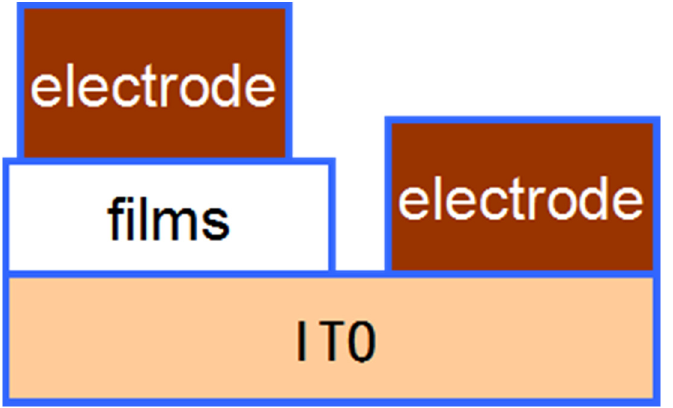
Figure 3. Structural schematic for measuring the conductivity of